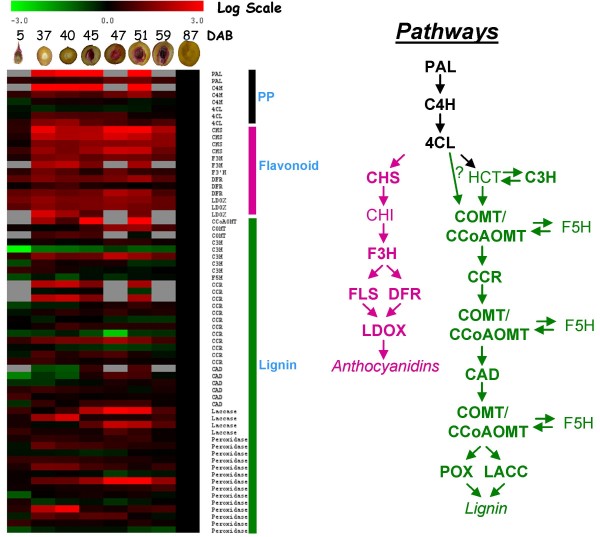
Induction of the phenylpropanoid pathway (PP), lignin and flavonoid pathways during fruit development. A heat map is shown for all significant PP, lignin and flavonoid pathway genes from the combined peach and apple microarray data. Log2-fold expression scale is shown at top. Developmental times are indicated as days after bloom along with a fruit image stained for lignin deposition. Gene abbreviations are listed along with colour coded bars indicating the corresponding pathway. A sketch of the PP, lignin and flavonoid pathways is shown on the right. Names for induced genes as determined from the array data are shown in bold.